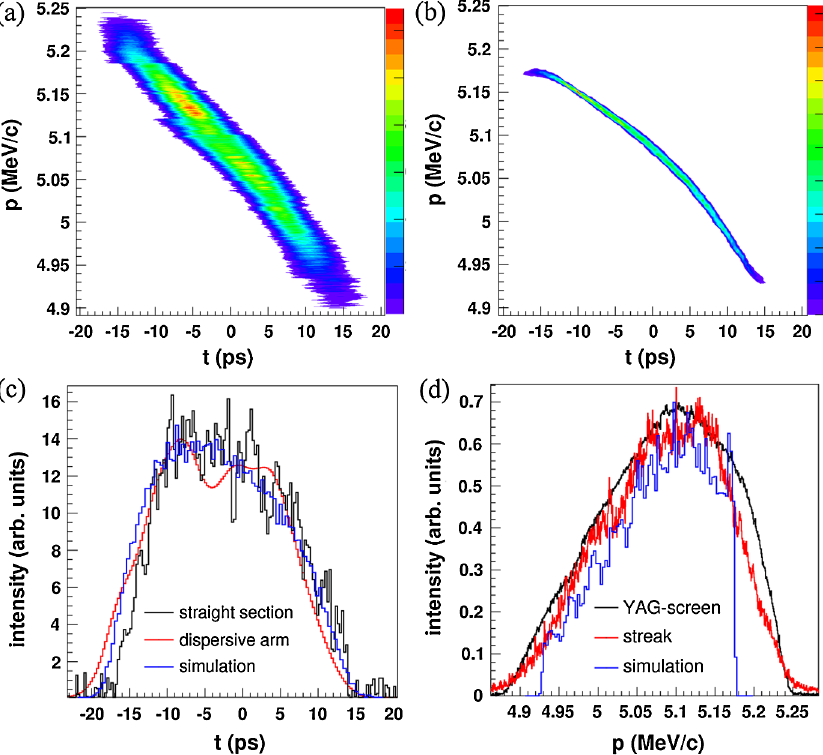
FIG. 28. (Color) Measured (a) and simulated (b) longitudinal phase space and projections: longitudinal (c) and momentum (d) distribution for 1.1 nC bunch charge, phase of maximum mean momentum gain plus 10 degrees and a longitudinal laser distribution with about 20 ps FWHM pulse